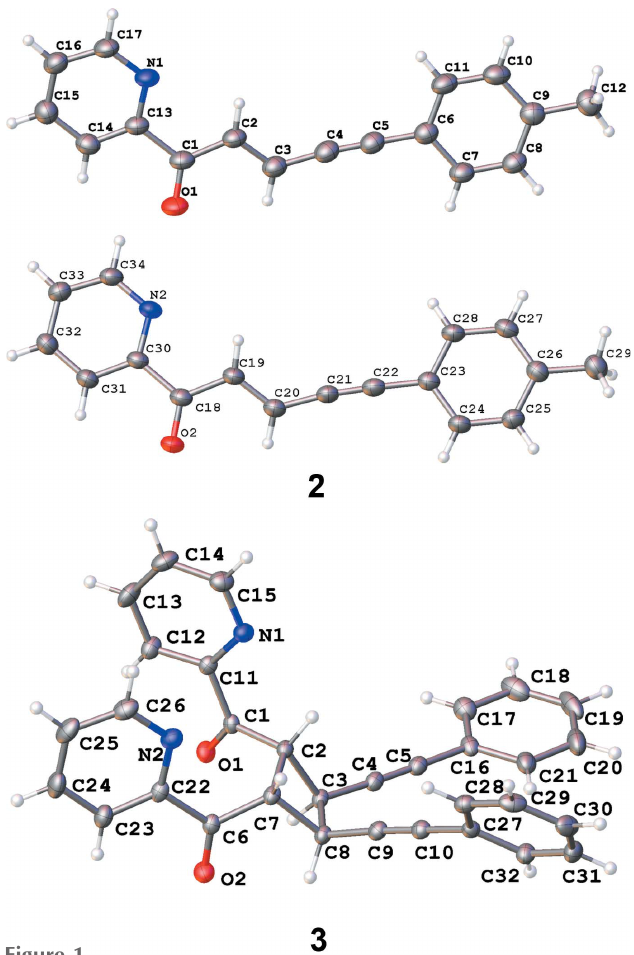
Figure 1 The molecular structure of 2 and 3 , showing the atom-labelling scheme. Displacement ellipsoids are drawn at the 50% probability level.